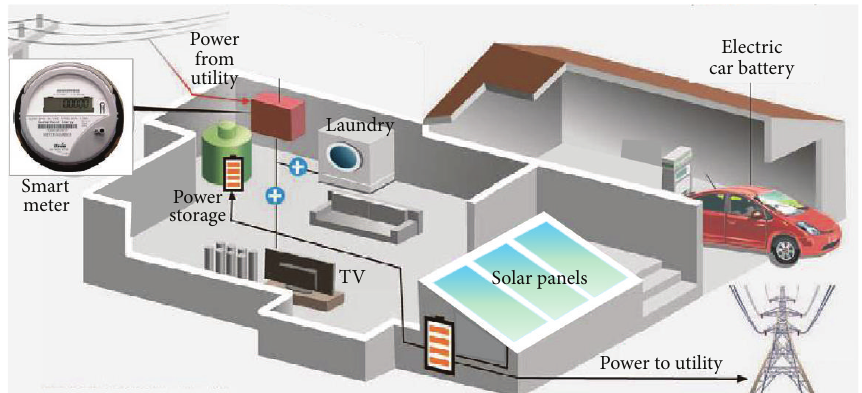
Figure 1: An electricity usage scheduling architecture with a smart meter.